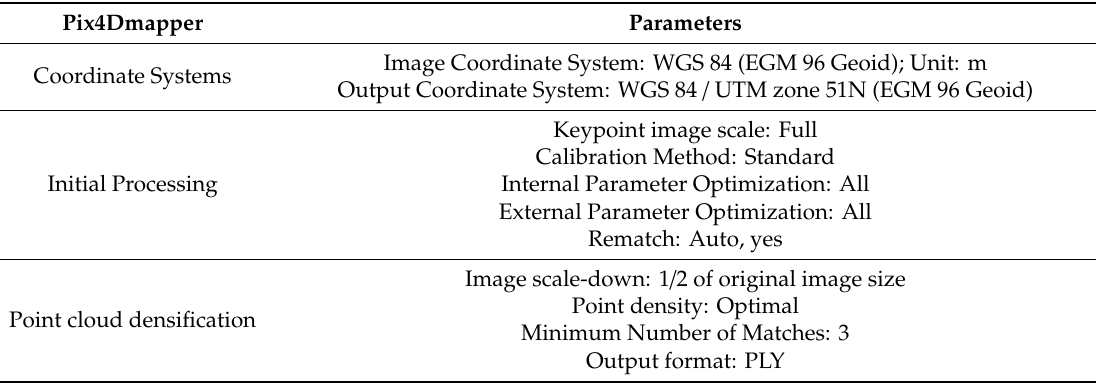
Table 1. Summary of parameters used for SFM processing in